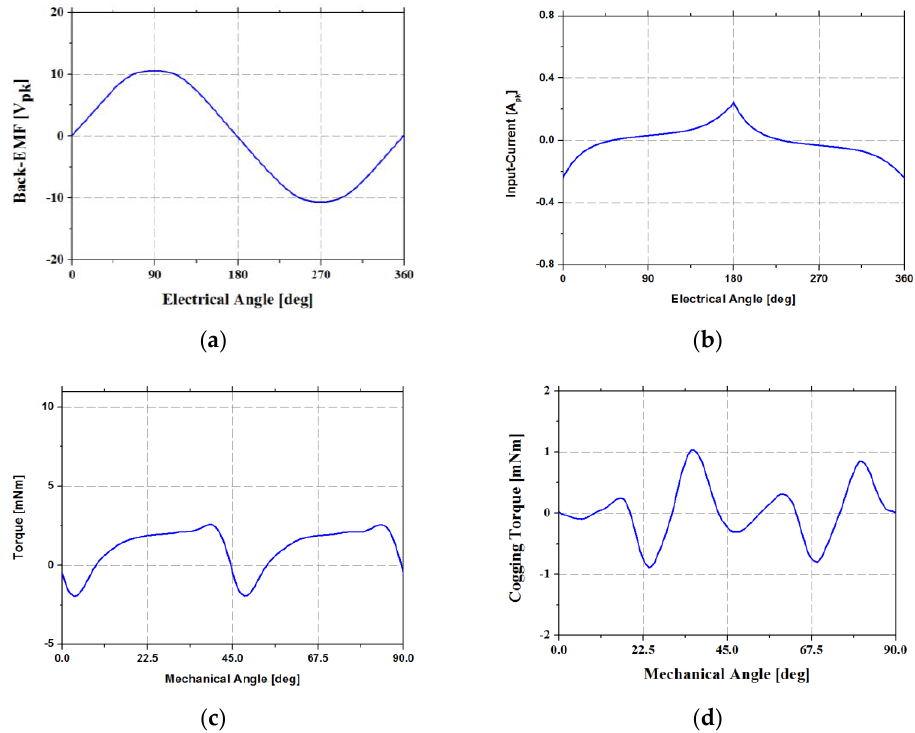
Figure 6. Voltage source analysis of the result of a single-phase claw-pole motor using finite element analysis: ( a ) wave-